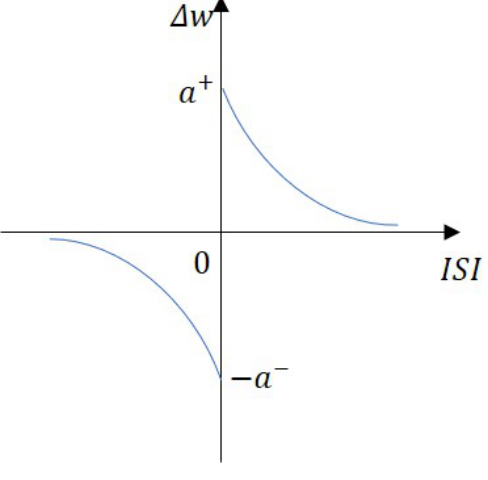
Figure 3. The STDP